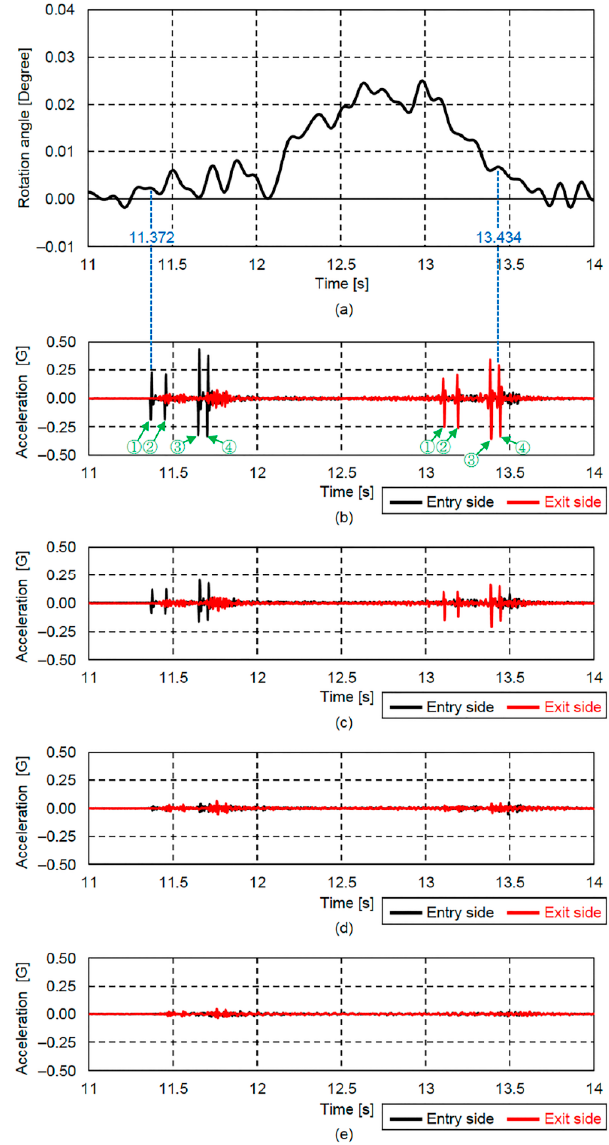
Figure 11. Vehicle entry and exit detection times based on acceleration records at the vertical stiffener both longitudinal edges of the main girder: ( a ) rotation angle response obtained using the two contact displacement gauges; ( b ) acceleration records at G2; ( c ) acceleration records at G3; ( d ) acceleration records at G4; and ( e ) acceleration records at G5.